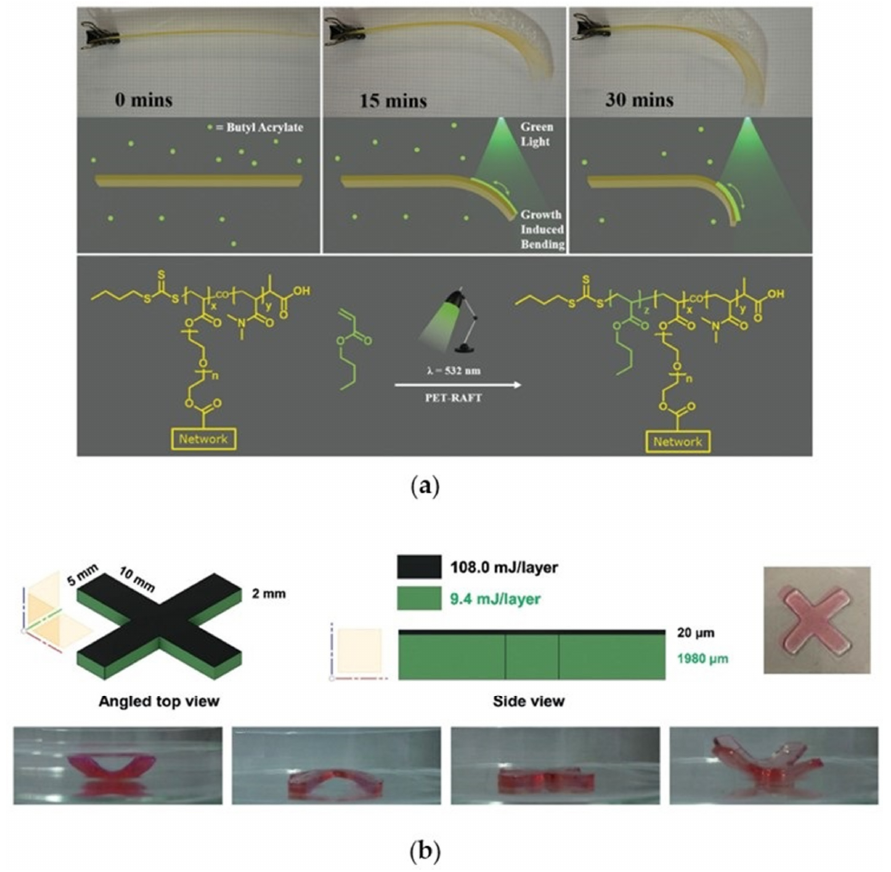
Figure 15. ( a ) Growth-induced bending process using PET-RAFT technique on a pre-printed strip. ( b ) Swelling induced actuation of spatially resolved 3D printed material in water. Reproduced with permission from ref.